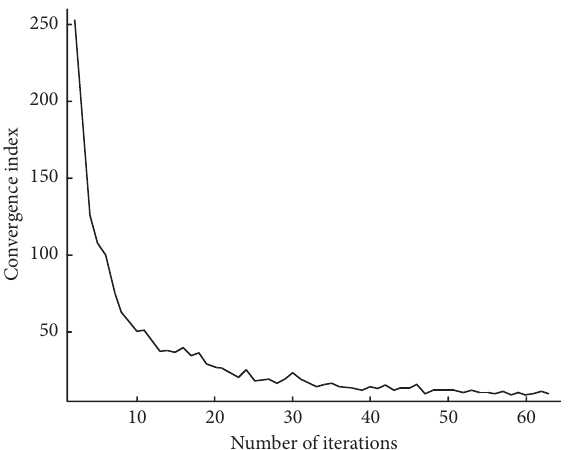
Figure 5: Changing curve of convergence indicator.